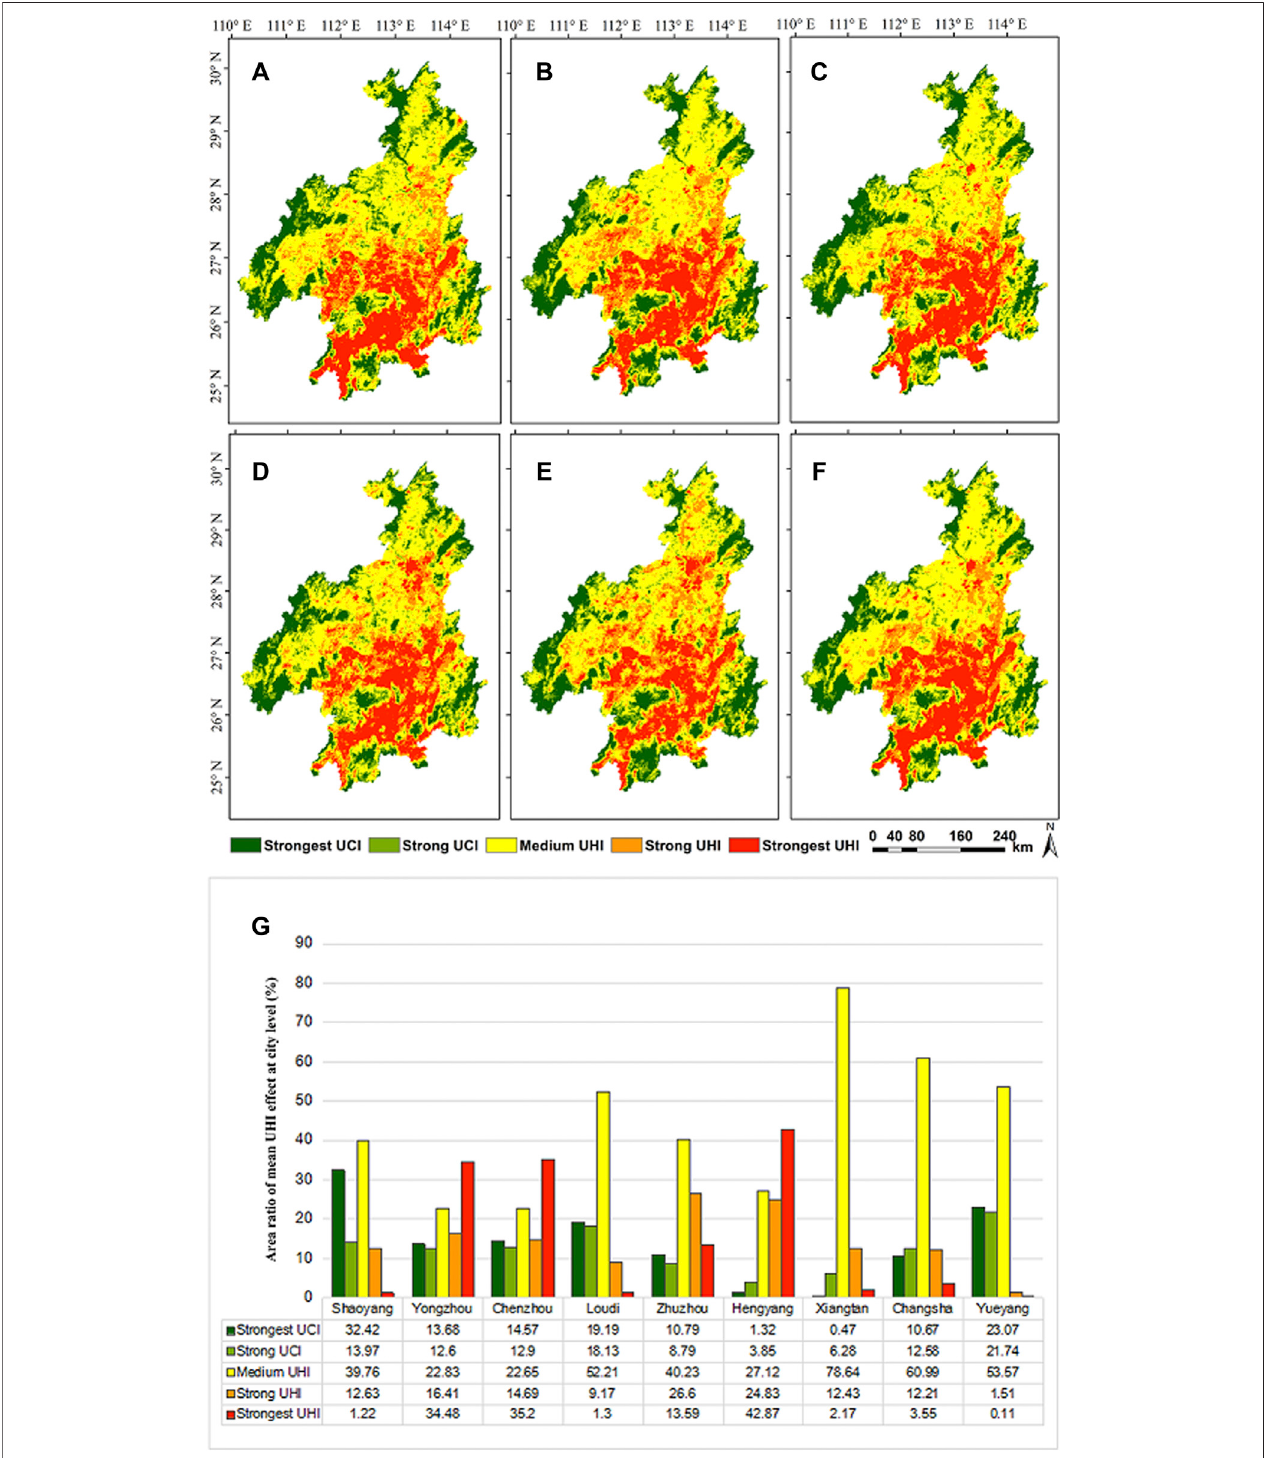
FIGURE 4 | Spatial pattern of the UHI effect in (A) 2000, (B) 2005, (C) 2010, (D) 2015, (E) 2018, (F) 18-year (2000 – 2018), and (G) area ratio of the 18-year mean UHI effect at the city level.